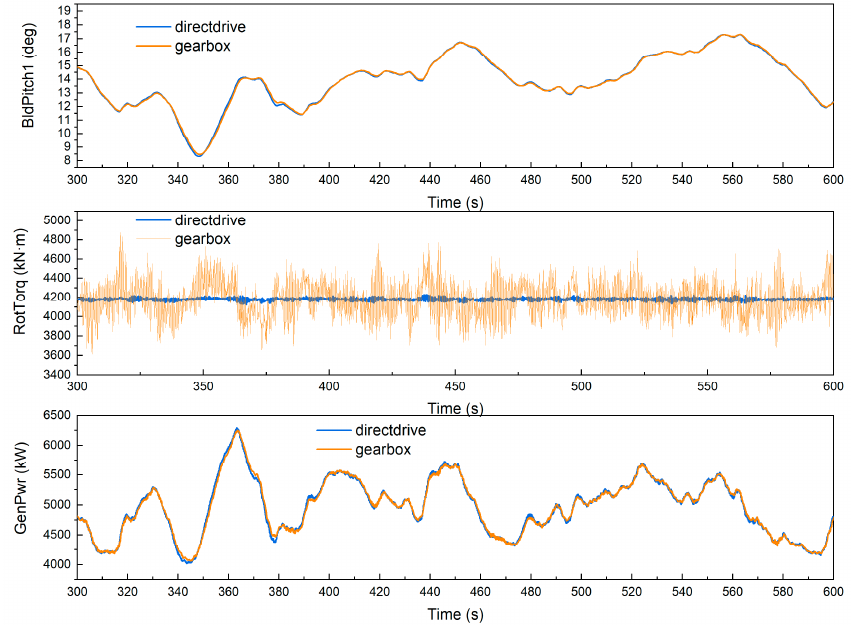
Figure 8. Validations of the control method on a direct drive floating offshore wind turbine (FOWT).